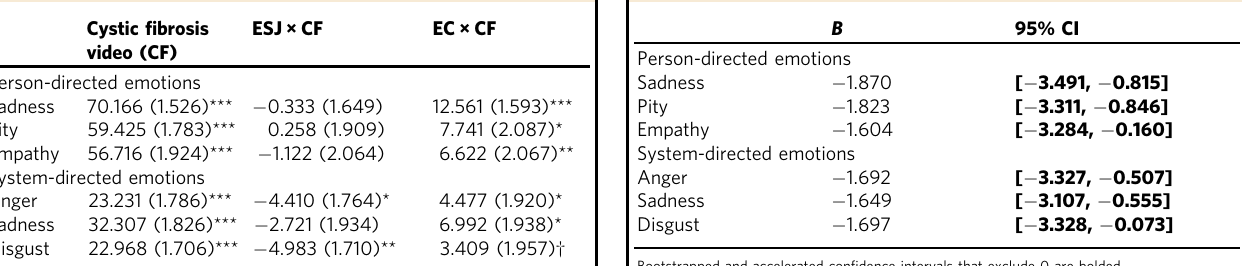
Table 3 Person- and system-directed emotions as a function of economic system justi fi cation (ESJ), empathic concern (EC), and exposure to the cystic fi brosis videos in Study 2.